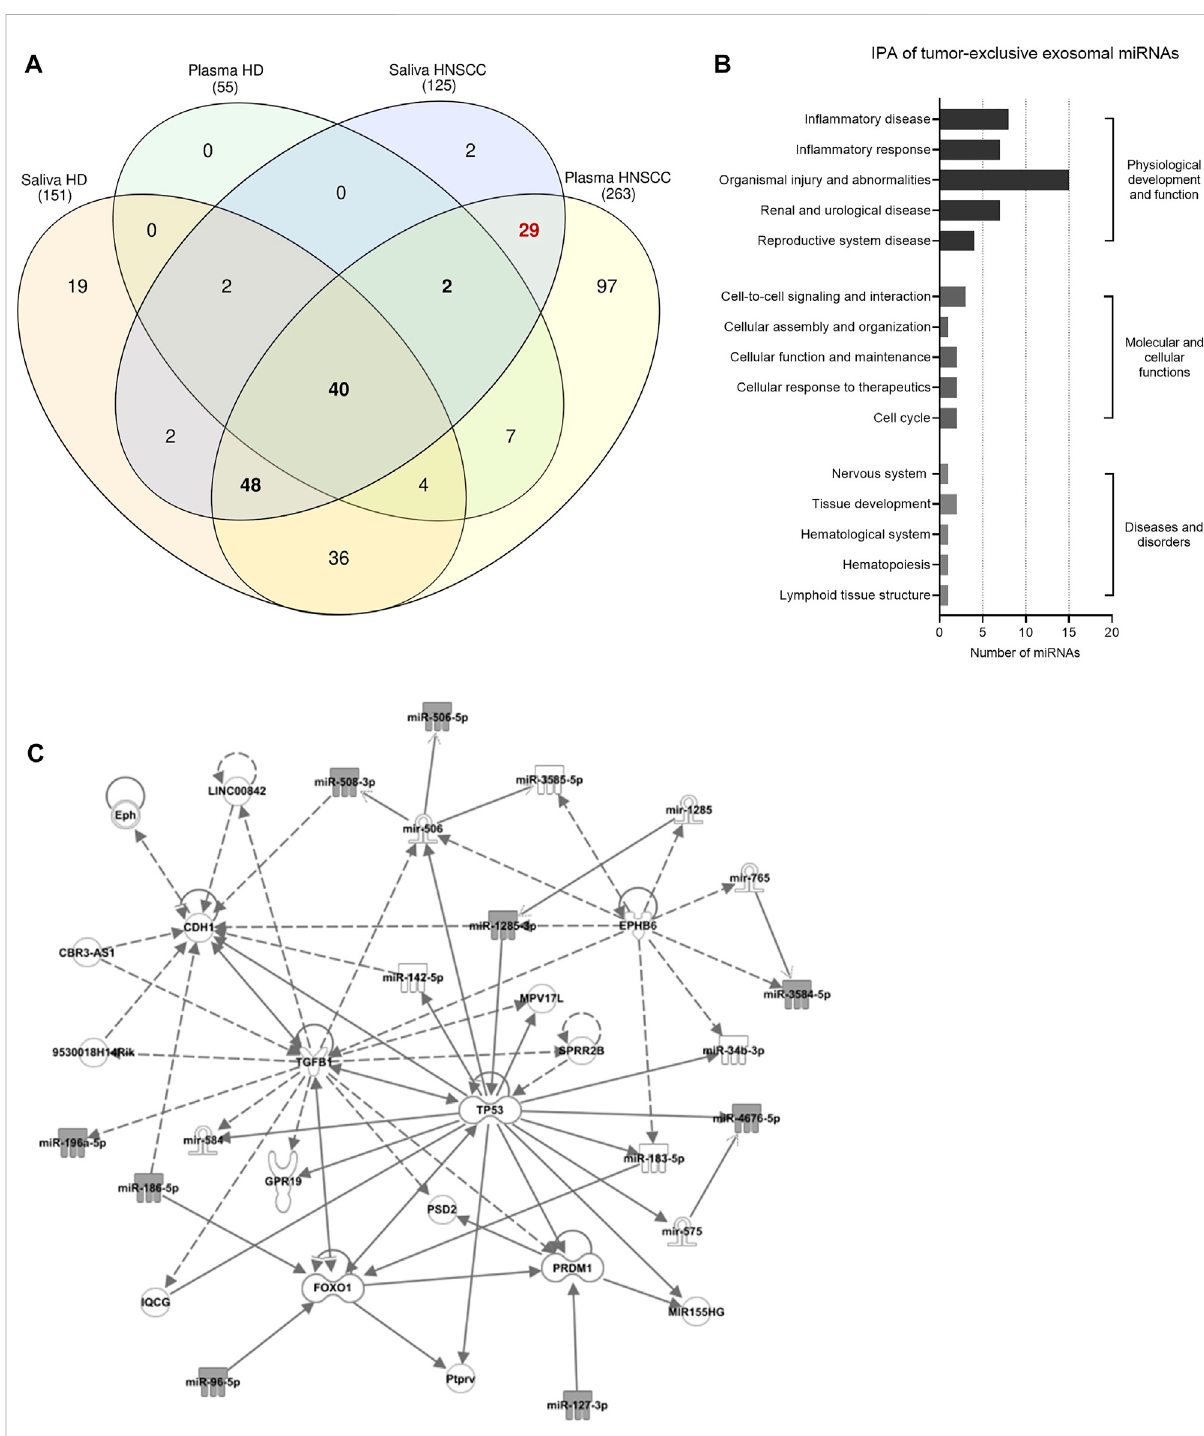
FIGURE 3 Identi fi cationoftumor-relatedandtumor-exclusivemiRNAsfromplasmaandsalivaofHNSCCpatientsandtheirinvolvementintumorigenesis. (A) Venn diagram of exosomal miRNAs detected in plasma and saliva of healthy donors (HD, n = 5) and HNSCC patients ( n = 11) to identify tumor- related(i.e.,overlapbetweenHNSCCplasmaandHNSCCsalivaandpresenceinHDplasmaand/orHDsaliva)andtumor- exclusive exosomalmiRNAs (i.e., overlap between HNSCC plasma and HNSCC saliva while absent in both HD bio fl uids). 90 tumor-related exosomal miRNAs are shown in boldand29tumor-exclusiveexosomalmiRNAsaremarkedinred. (B,C) IngenuityPathwayAnalysis(IPA)oftumor-exclusiveexosomalmiRNAsfrom plasma and saliva of HNSCC patients ( n = 11). (B) Shows diseases and biological functions most signi fi cantly associated with the identi fi ed tumor- exclusive miRNAs. Categories withinagroupareshowninincreasingorderof p -value. (C) Showstheinvolved cancerrelatednetwork.Grey-colored symbols represent miRNAs identi fi ed in this study. Solid lines indicate direct interaction, dashed lines indicate indirect